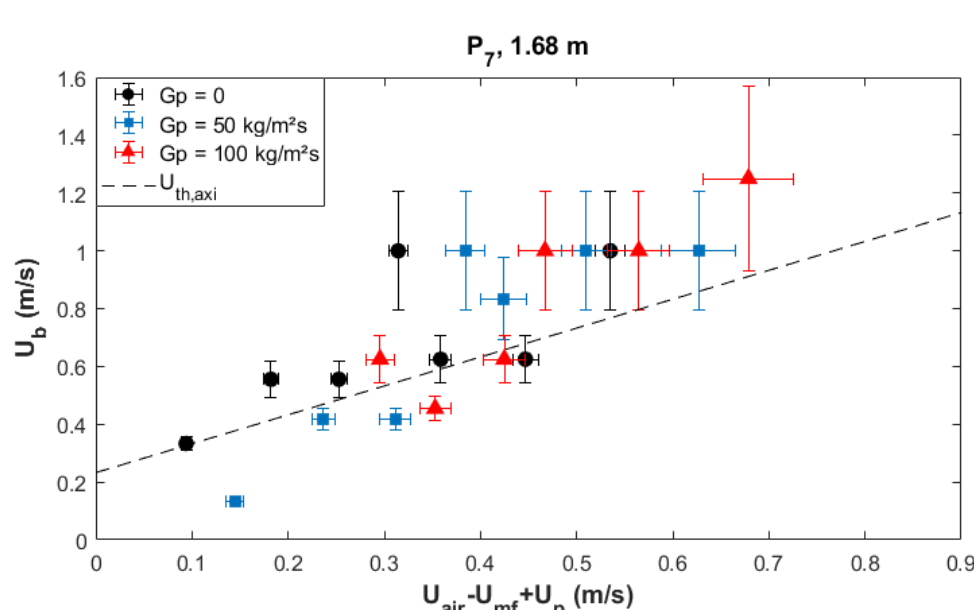
Figure 16. Evolution of the upward velocity measured with the cross-correlation function at 1.68 m above the aeration versus U air − U mf + U p , with the particles mass flux as a parameter. The dashed line represents the velocities calculated by the two-phase theory for the case of axisymmetric slugs.